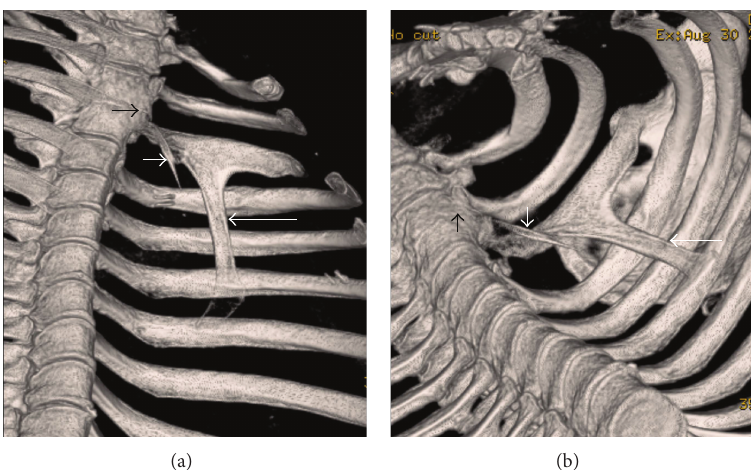
Figure 3: 43-year-old gentleman complaining of high grade fever, cough, and chest pain was investigated with chest radiographs and helical chest CT scan and subsequently diagnosed with intrathoracic ribs. Unenhanced chest CT, volume rendered-3D images, coronal view in (a) and coronal oblique view in (b) reveal fusion of anterior aspects of the T2 and T3 vertebral bodies (short black arrow), a supernumerary second rib (thin, short, and obliquely oriented) with predominantly fibrous (non-ossified) proximal and distal parts originating from the second costovertebral neoarticulation (short white arrow), and the obliquely oriented bifid arm of the third rib coursing into the thoracic cavity (long white arrow).